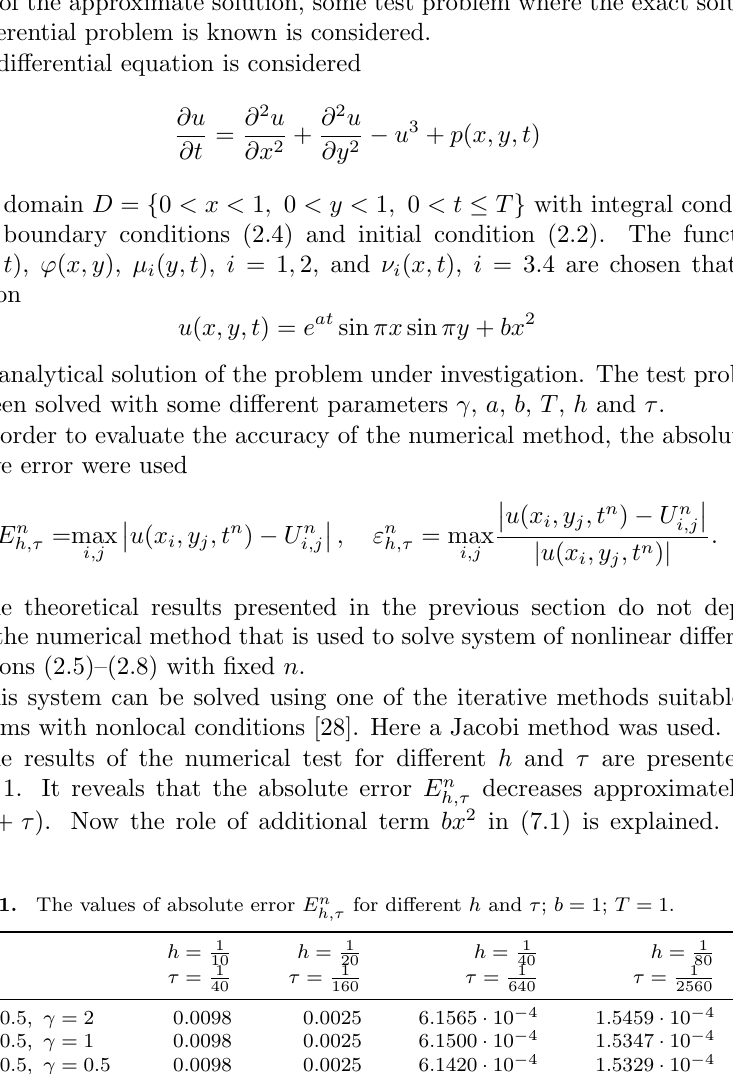
for different h and τ ; b = 1; T = 1 . h,τ h = 1